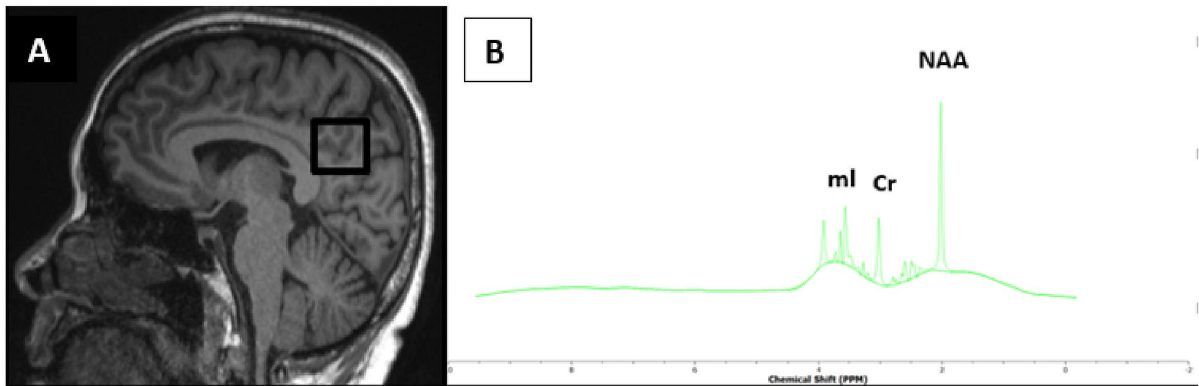
Fig 4. A midsagittal T 1 -weighted image of the brain of a healthy volunteer. A 2 x 2 x 2 cm 3 voxel placement in the PCC/Prec is shown in A . The proton spectra obtained from the region with a TE of 30 ms depicts the NAA, Cr, and mI metabolites in B .